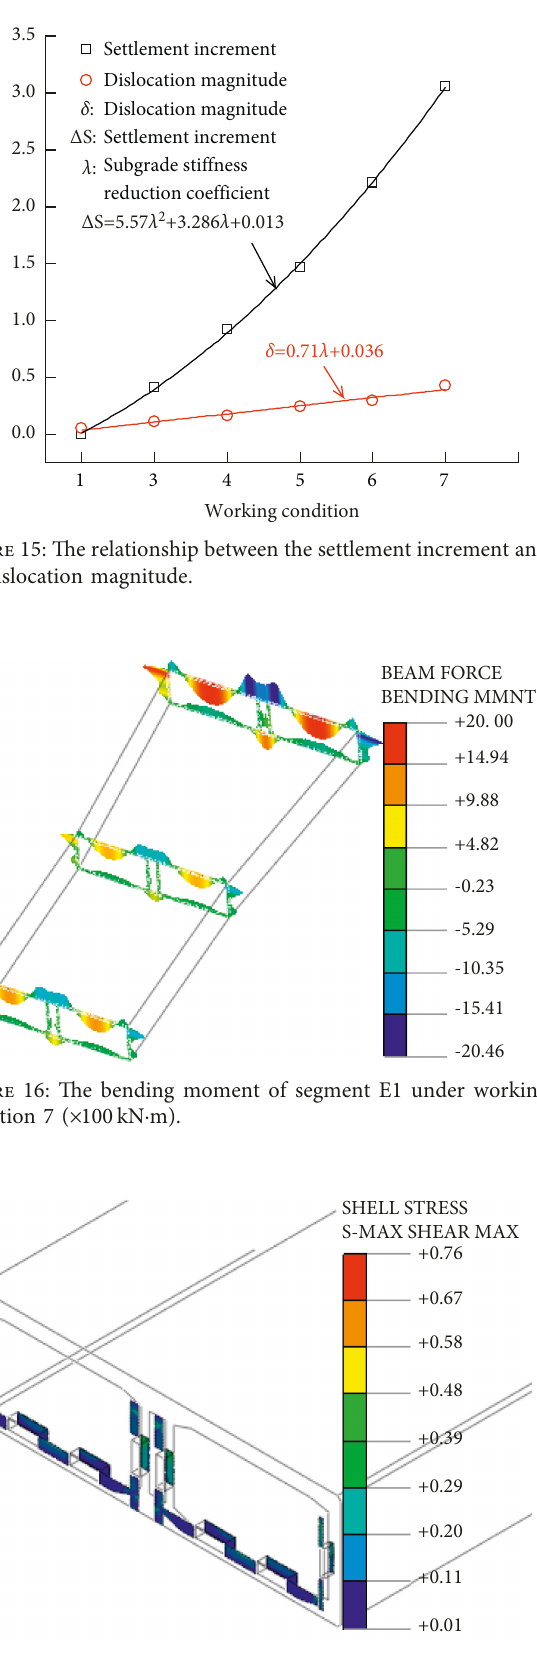
Figure 17: The nephogram of the shear stress on joint 1 under different working conditions.